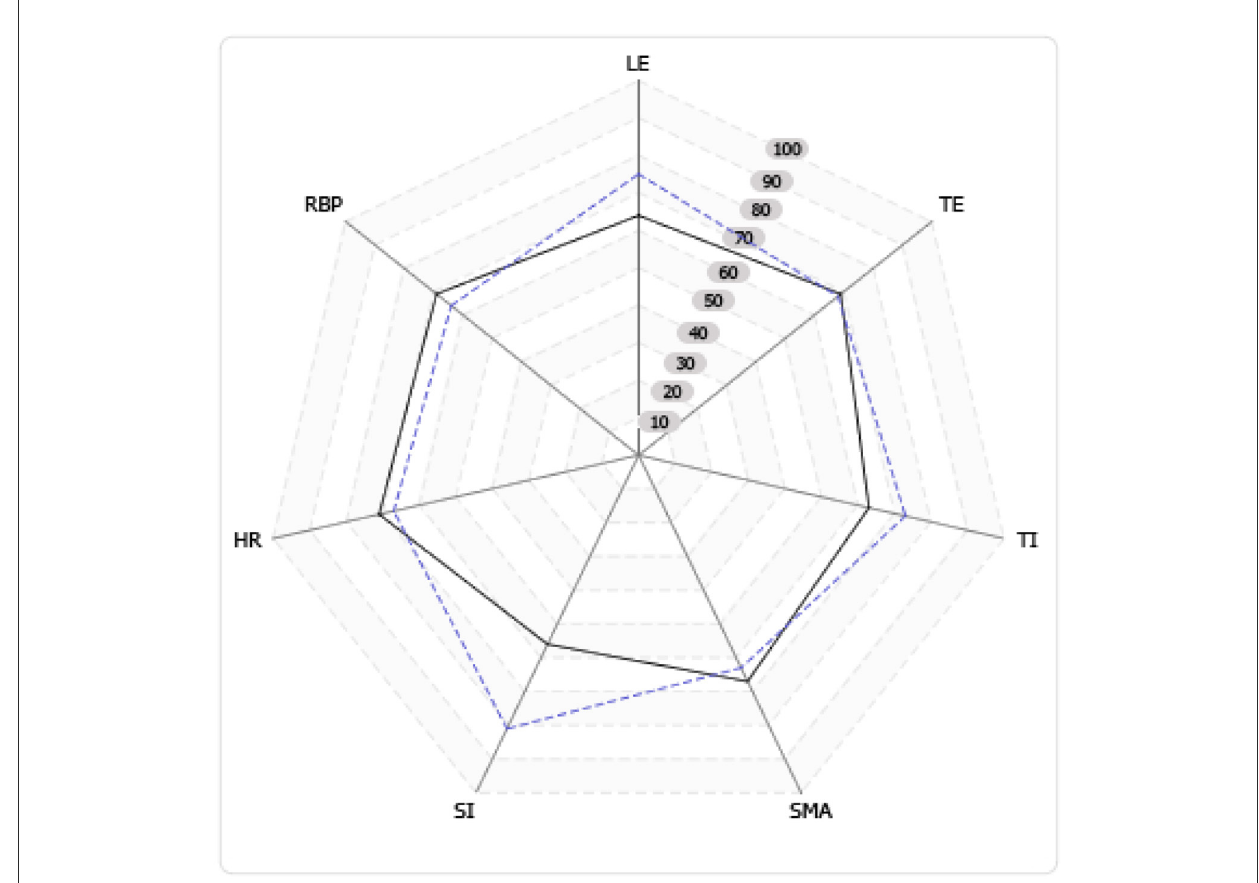
FIGURE1 Domain performance in the rehabilitation unit against average in Canada (dotted line represents the studied unit). With reference to Table